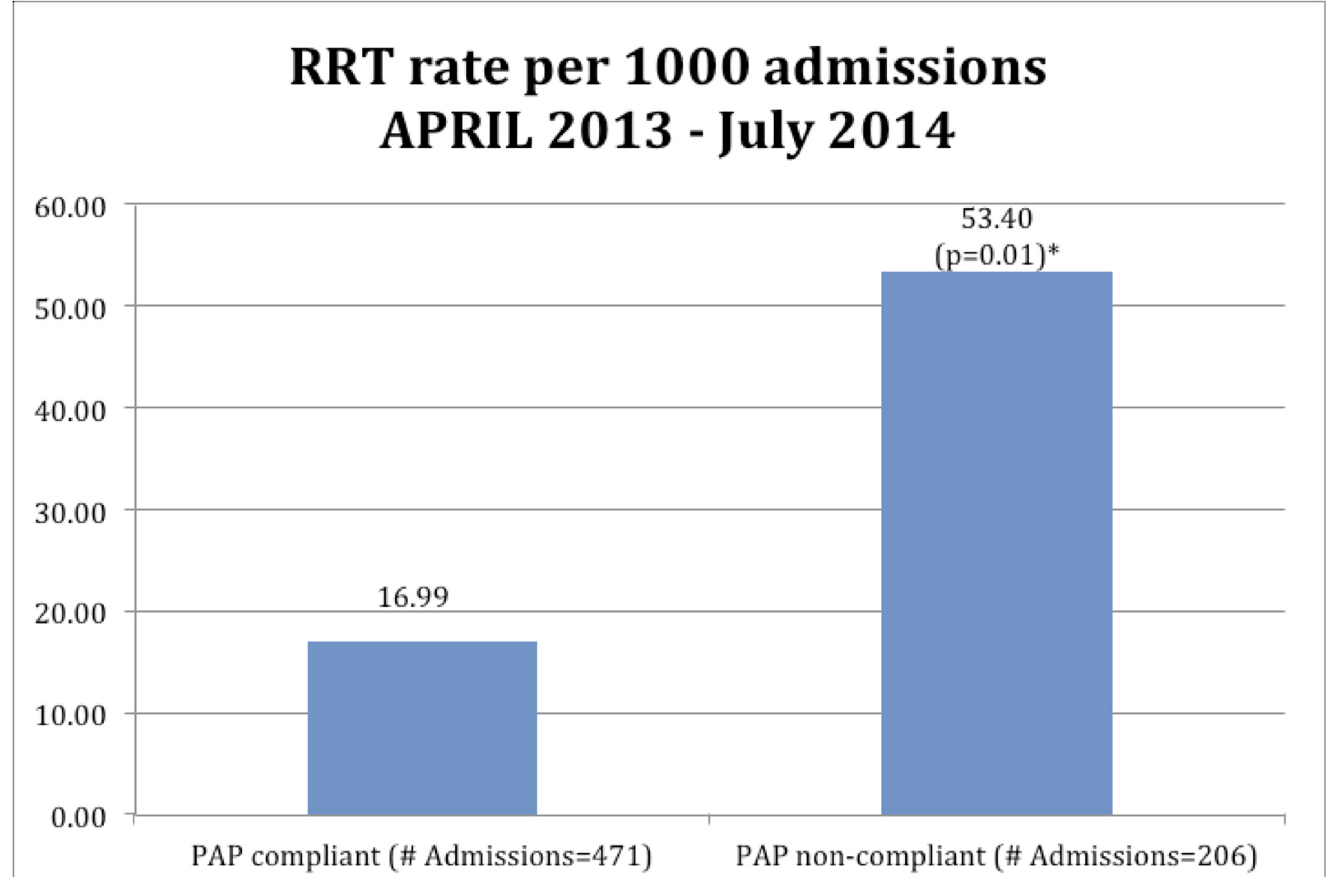
Fig 2. Comparison between patients who were compliant with PAP therapy versus non-compliant, from April 2013 to July 2014.